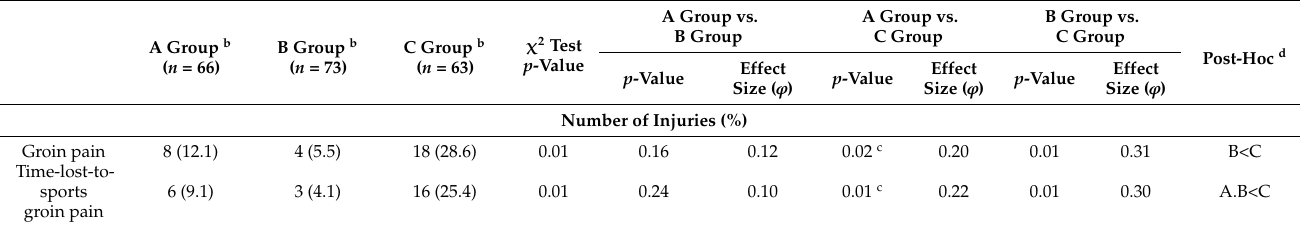
Table 3. Frequency of groin pain by number of groin pain injuries a .